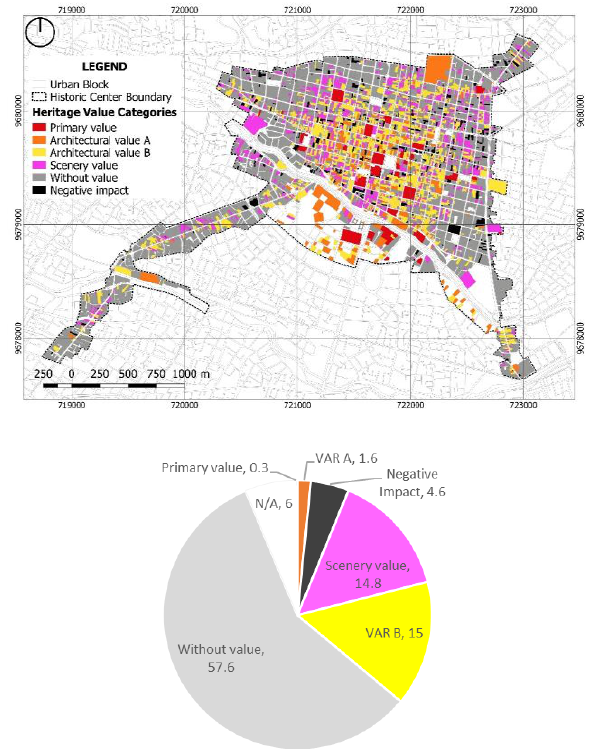
Figure 1. Map of the inventoried buildings in the historic centre of Cuenca - Ecuador.